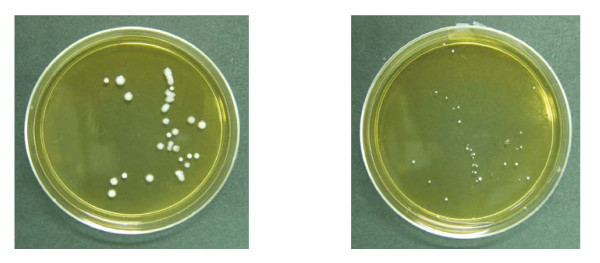
Growth of Lactobacillus acidophilus in culture plates.